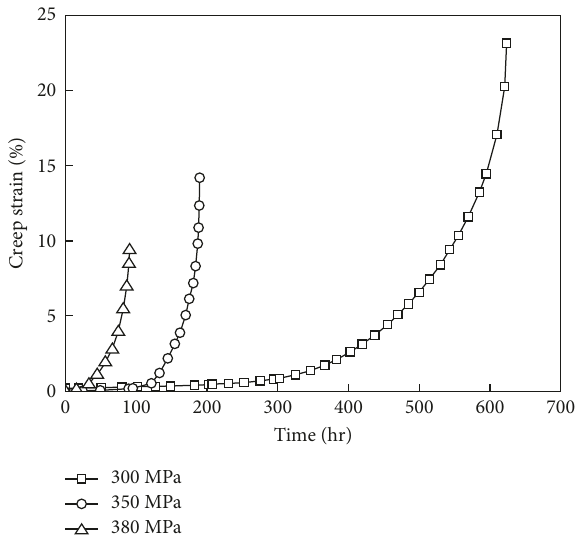
Figure 7: Creep curves of cast Haynes 282 alloy at 750 ° C.